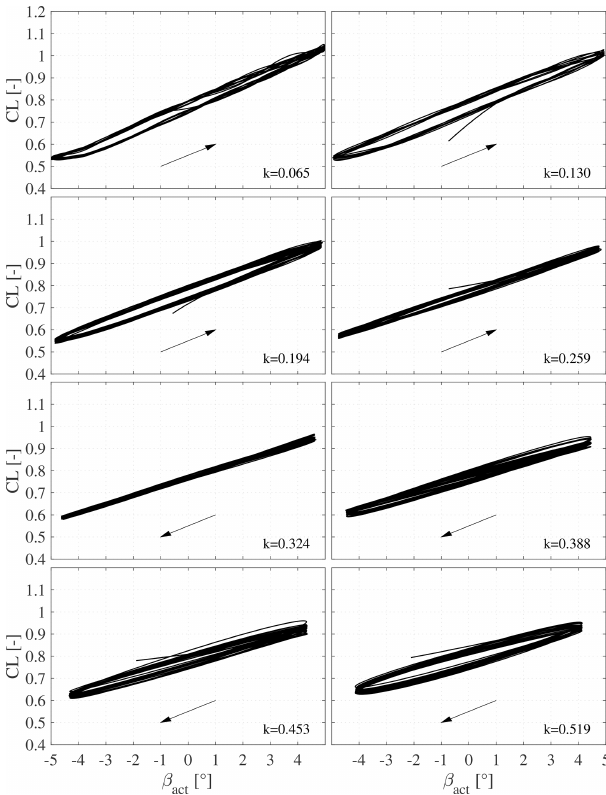
Figure 15. C L over actual flap angle for increasing frequencies. The arrow indicates the sense of rotation of the loop. Up to the fre- quency of k = 0 . 259 the sense is counterclockwise, and it is clock- wise for higher frequencies.